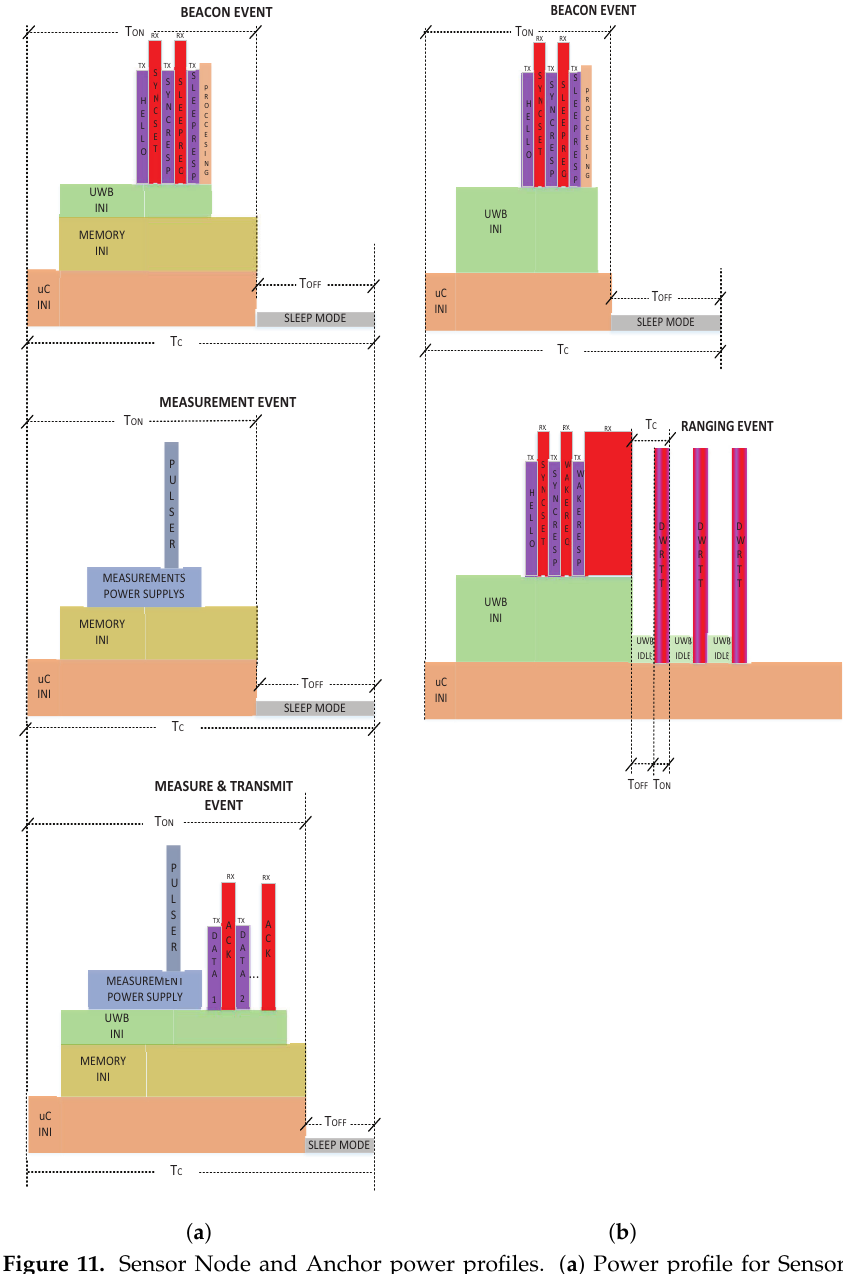
Figure 11. Sensor Node and Anchor power profiles. ( a ) Power profile for Sensor Node events. ( b ) Power profile for Anchor